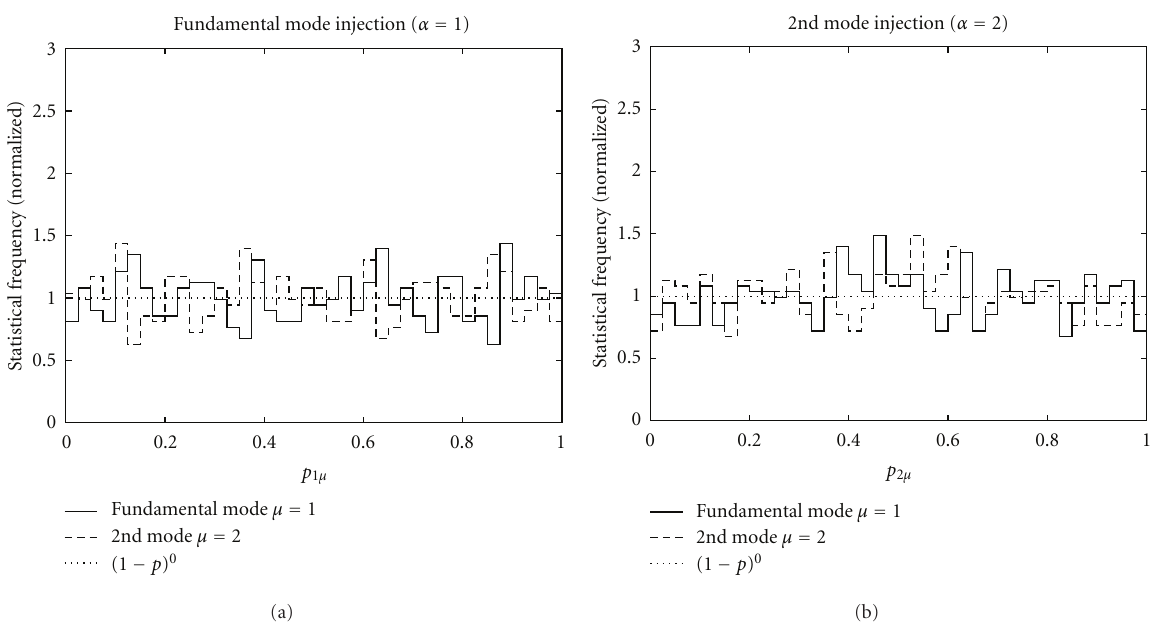
Figure 13: Frequency distributions for the fraction p αμ of each propagating mode in the transmission current carried by each propagating mode when each of three propagating modes is incident for Kd =